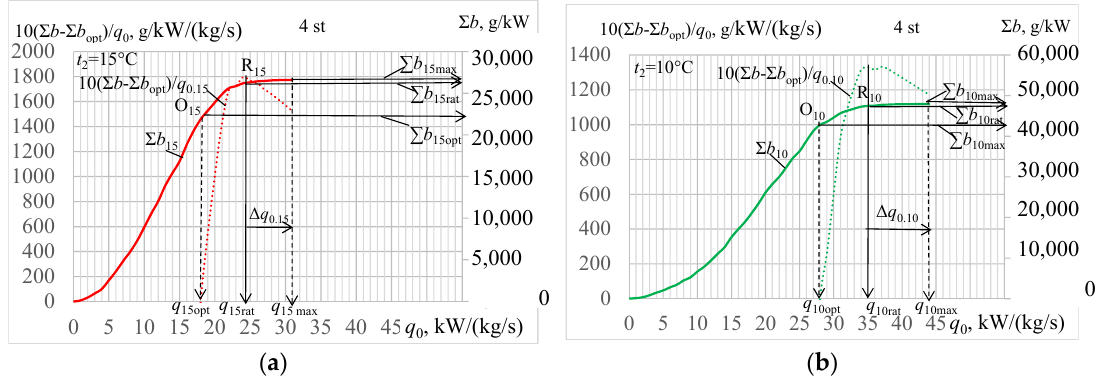
Figure 9. Relative increments of annual specific fuel reduction ∑ b / q 0 and ( ∑ b − ∑ b opt )/ q 0 for t a2 = 15 °C ( a ) and 10 °C ( b ) against specific cooling capacity q 0. Energies 2020 , 13 , x FOR PEER REVIEW